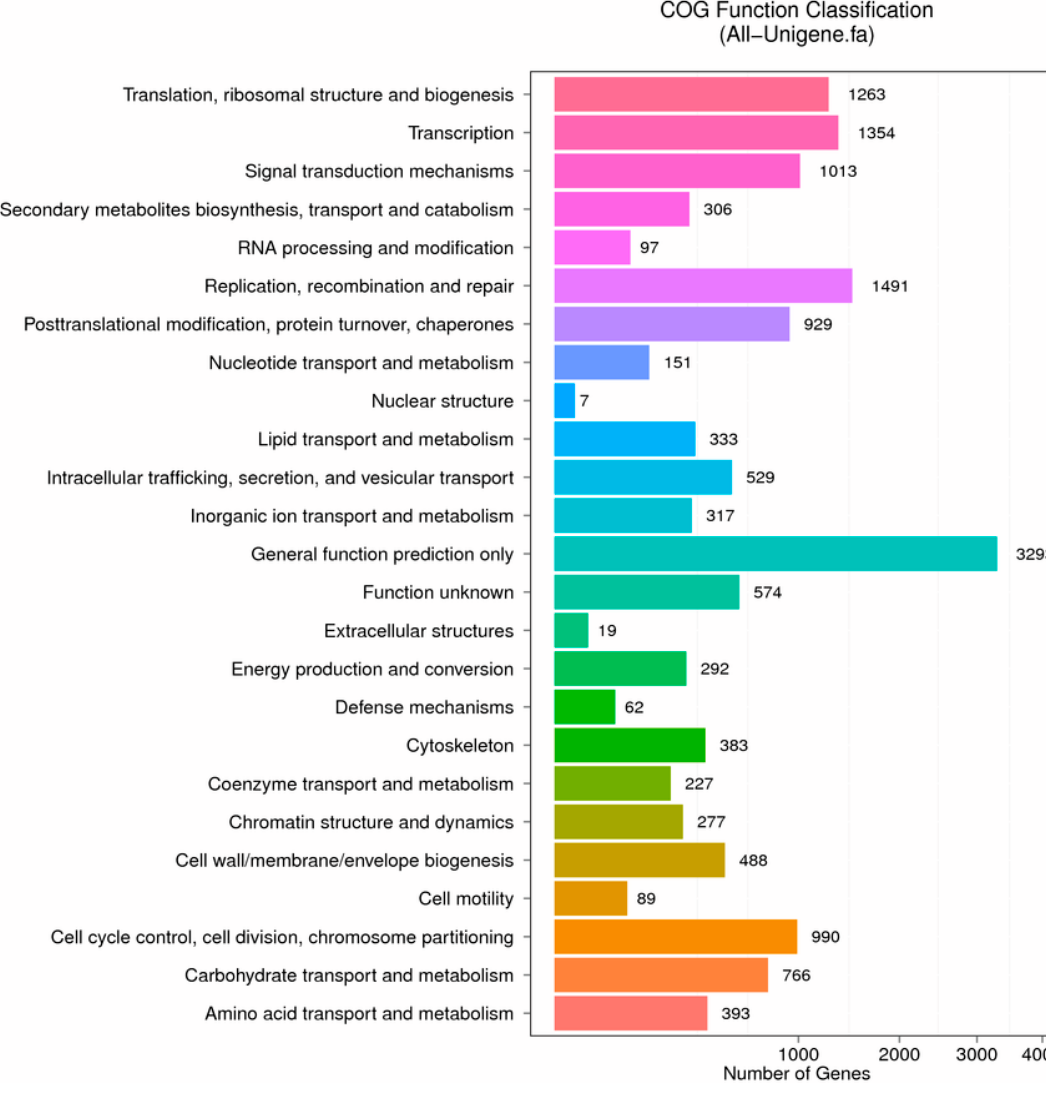
Figure 1. The cluster of orthologous groups (COG) classification. 8913 (23.63% of the total annotated putative proteins) were grouped into 25 different categories.